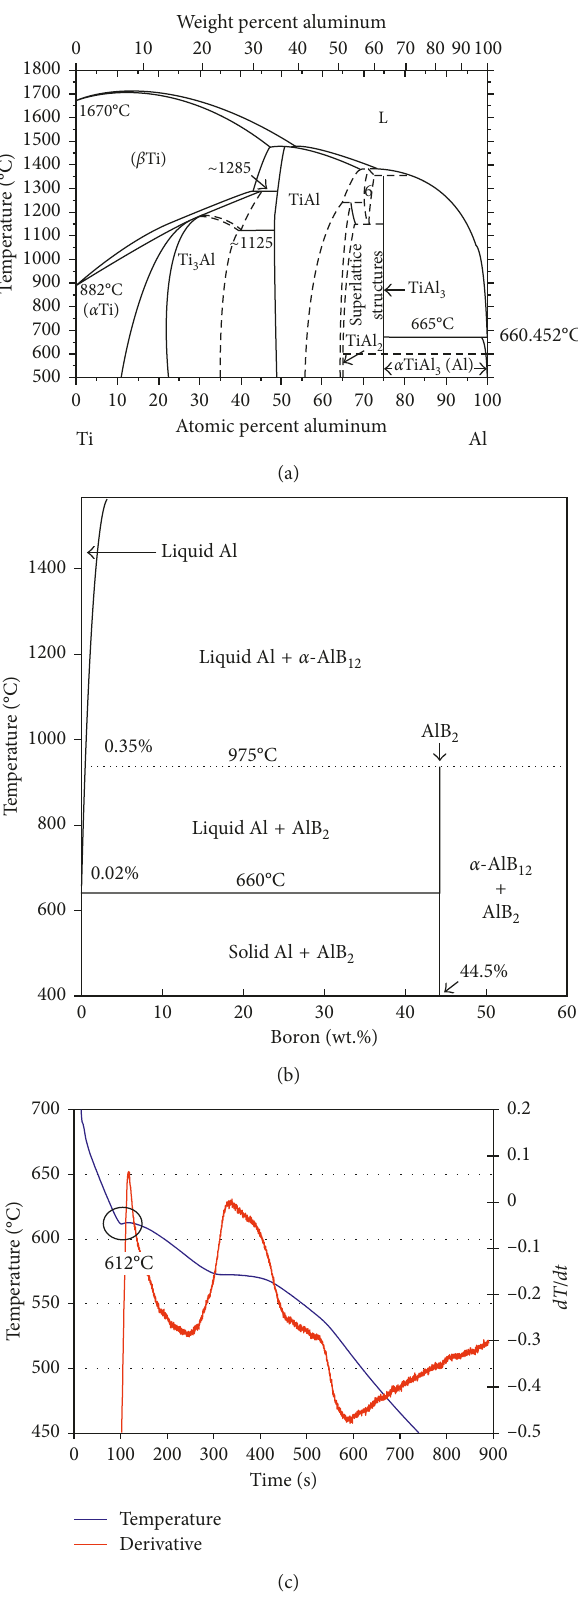
Figure 1: (a) Al-Ti phase diagram [3]. (b) Aluminum-rich corner of the Al-B phase diagram [6]. (c) Temperature-time curve ob- tained from the A356.2 alloy